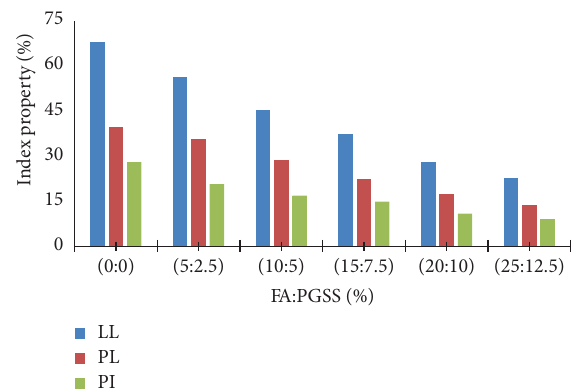
Figure 2: Index property of expansive soil mixed with FA and PGSS.